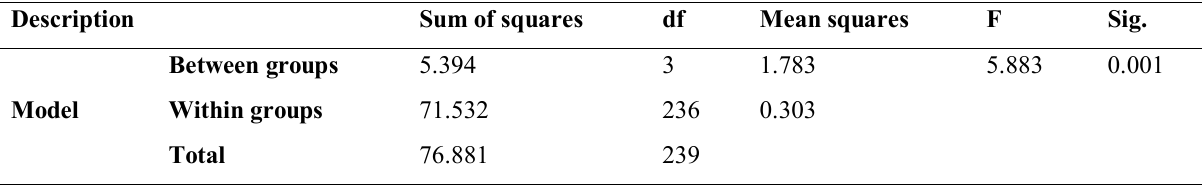
Table 16-ANOVA (comparing the ROA of different sectors at high investment